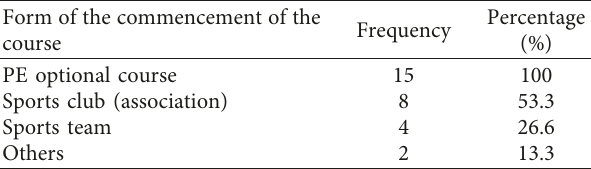
Table 5: Open class form survey statistics ( n � 15).